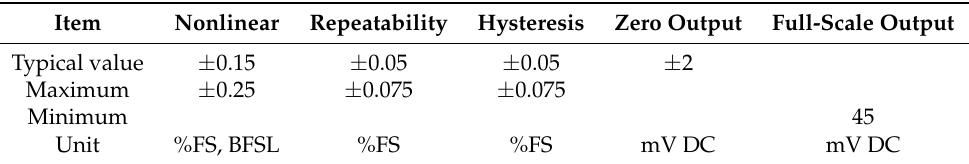
Table 1. The selected sensor core